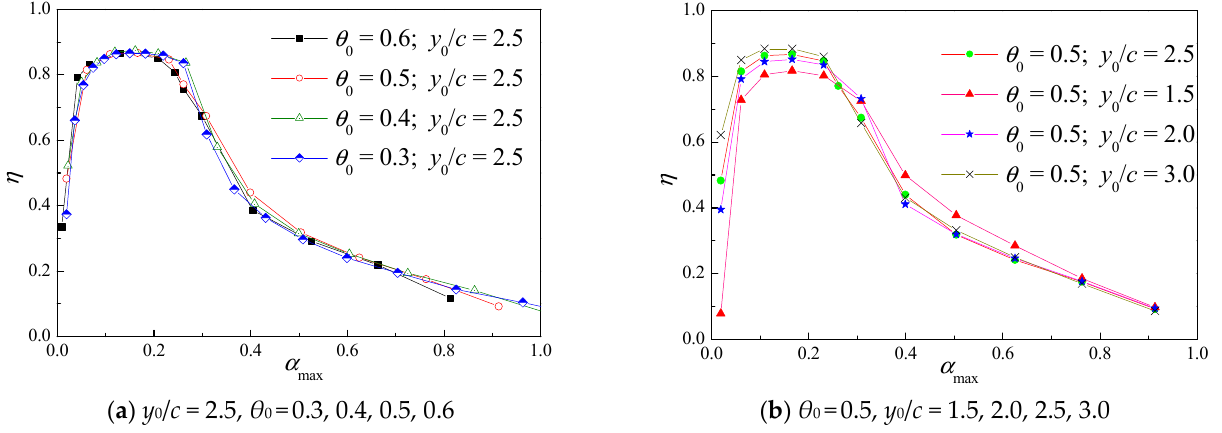
Figure 12. Effect of maximum AOA on the efficiency for two series flapping foil.